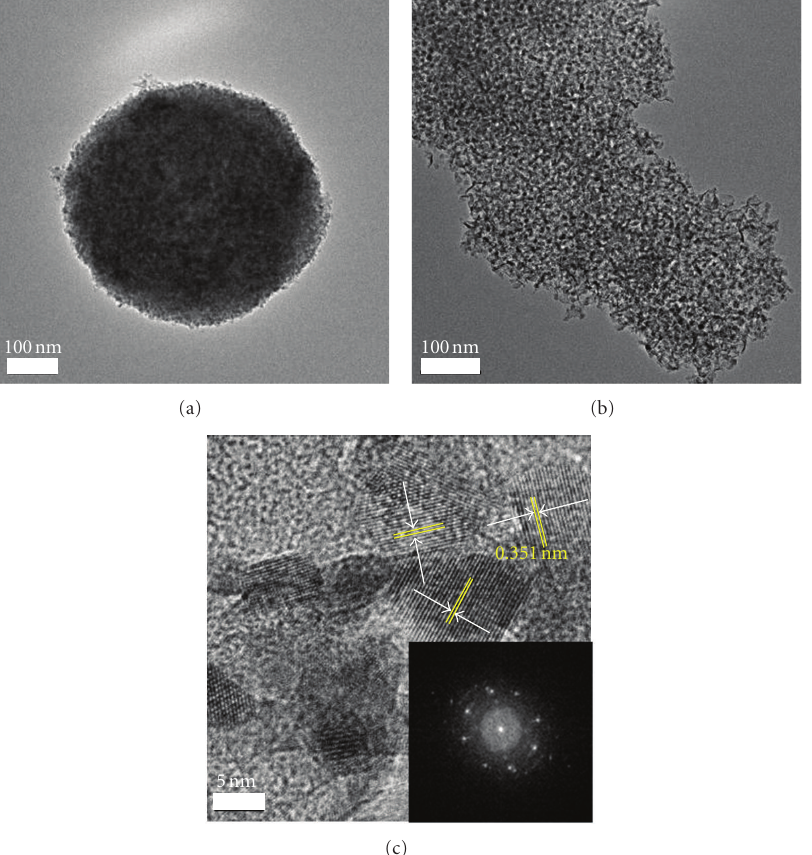
Figure 3: ((a) and (b)) TEM images. (c) HRTEM image and fast Fourier transform (FFT) pattern (inset) of the as-prepared mesoporous TiO 2